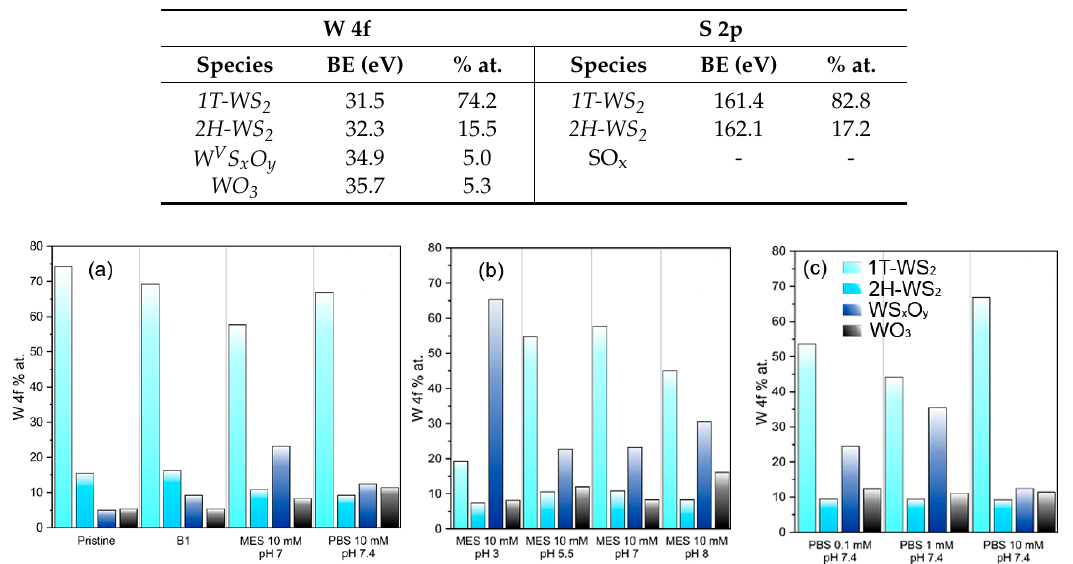
Table 3. XPS of pristine WS 2.